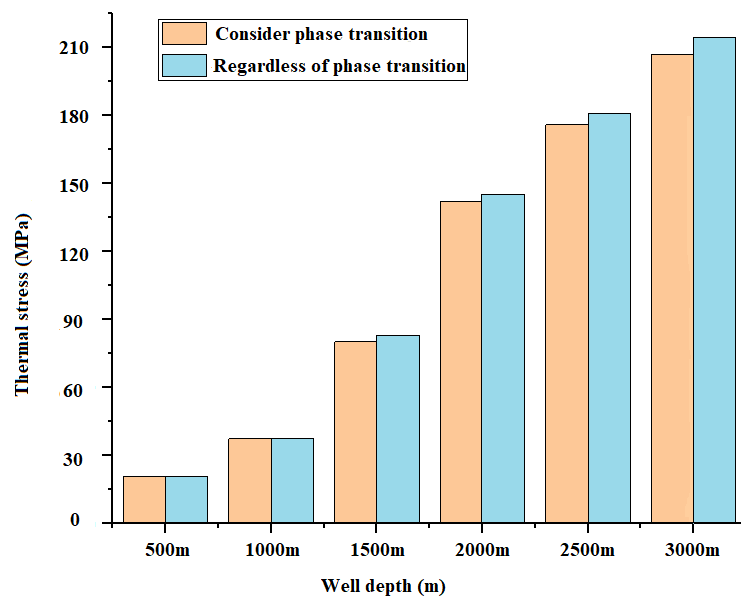
Figure 7. Comparison diagram of thermal stress in two injection strings. Table 4. Deformation of tubular string during CO 2 injection in four wells .